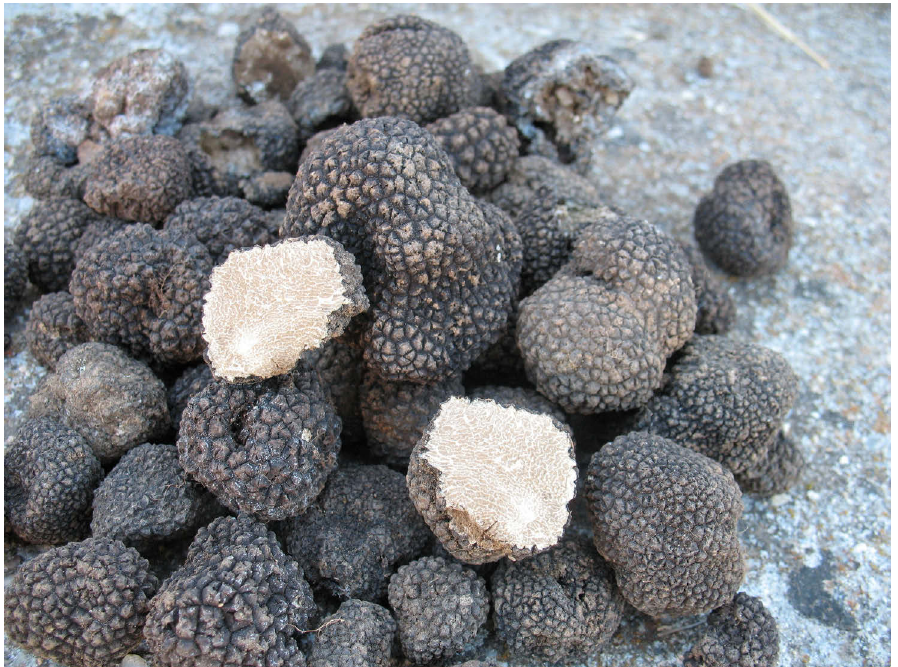
Fig. 2. An impressive collection of Tuber aestivum collected in the morning of July 21